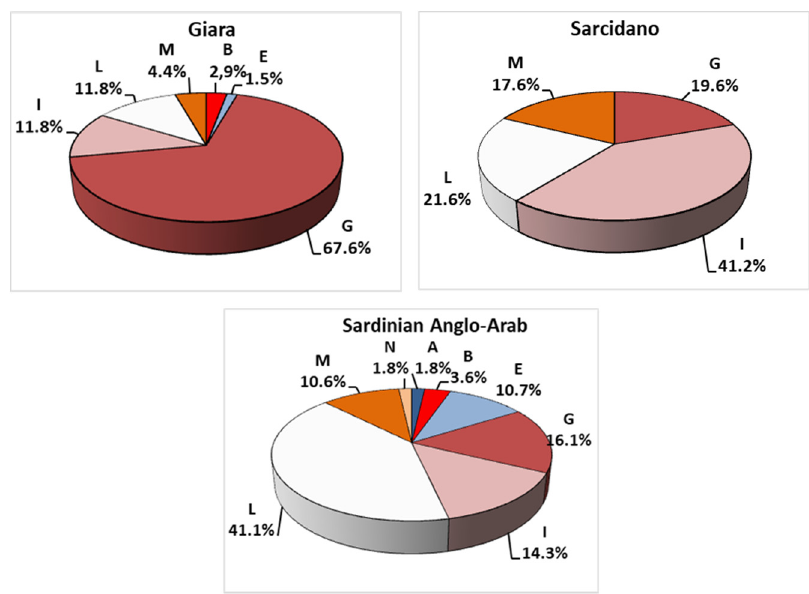
Figure 4. MtDNA haplogroup frequency distribution of 175 sequences belonging to the three Sardinian breeds available from GenBank. Three sequences not classified in mtDNA haplogroups (JF804119, JF804147, and JF804151) were excluded from the analysis.